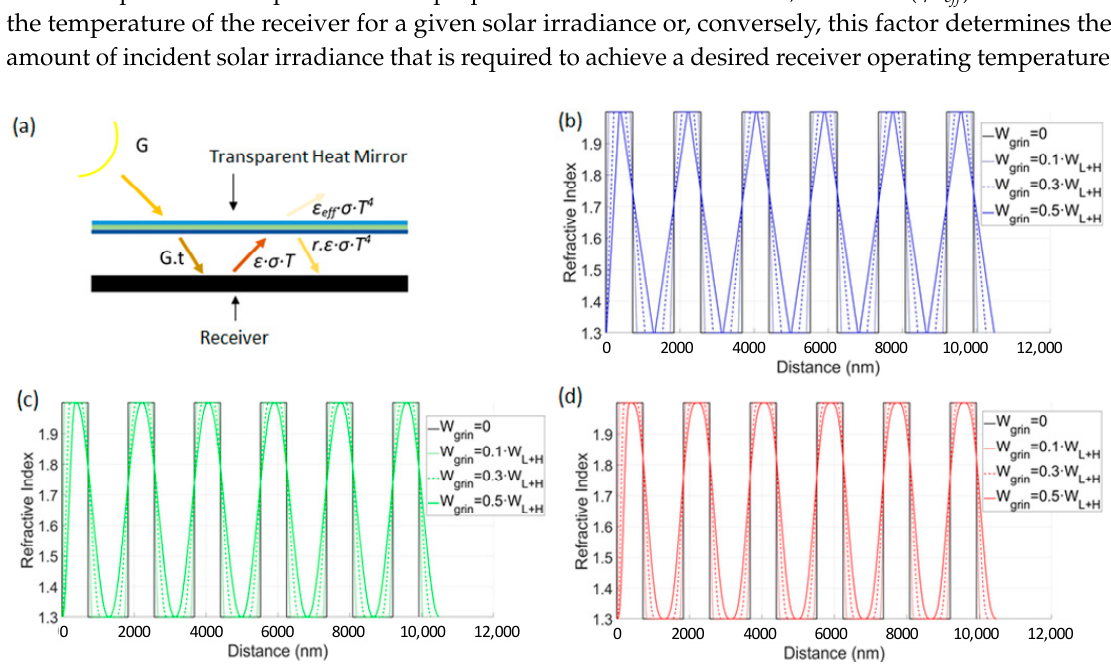
Figure 1. ( a ) Schematic diagram of a solar receiver with a transparent heat mirror cover. Refractive index profile of one-dimensional (1-D) transparent photonic crystal heat mirrors with ( b ) linear (H L [L L H L ] 5 ), ( c ) cubic (H C [L C H C ] 5 ), and ( d ) quintic (H Q [L Q H Q ] 5 ) interfacial profiles for different W grin values equal to 0.1·W L+H to 0.5·W L+H.